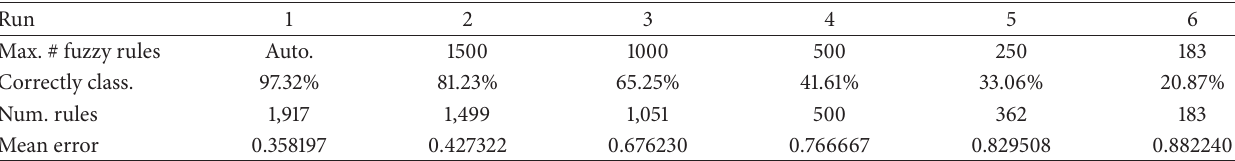
Table 4: Round 4. Data separated by gender for some species (see the Appendix); 3,660 patterns presented for use in training; NEFCLASS-J default for learning rate was kept; number of MF for hue variables was 16; MF shape was trapezoidal; aggregation function was maximum; learning procedure was best per class ; all four learning constraints were used; maximum number of epochs was 500, minimum number of epochs was 10, and number of epochs after optimum was 25.